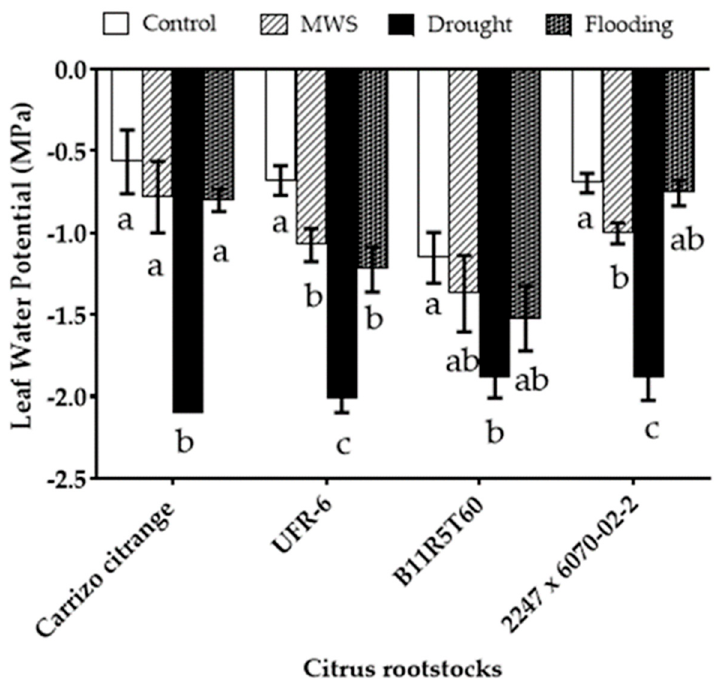
Figure 4. Leaf water potential (LWP; MPa) at the end of the trial with the four citrus rootstocks studied (Carrizo citrange, UFR-6, B11R5T60, and 2247 x 6070-02-2) and under the four water treatments (Control, MWS, Drought, and Flooding). Values in columns with different letters denote statistical differences among the treatments for each rootstock by Fisher’s LSD test ( p < 0.05). MWS: Medium Water Stress.